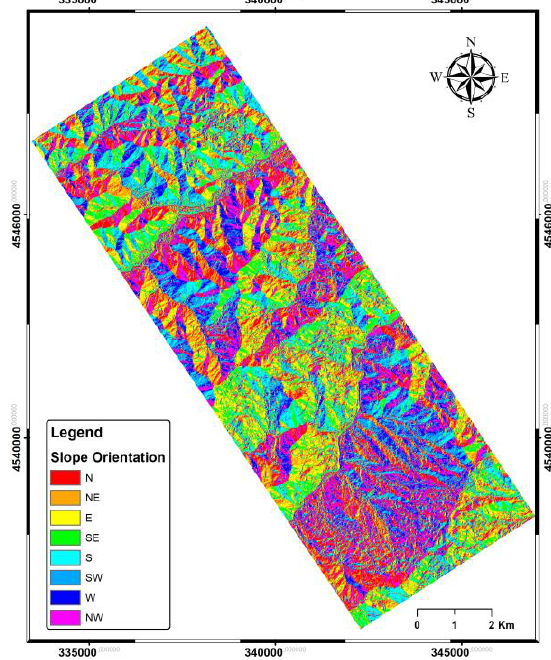
Figure 7. Slope aspect map of the study